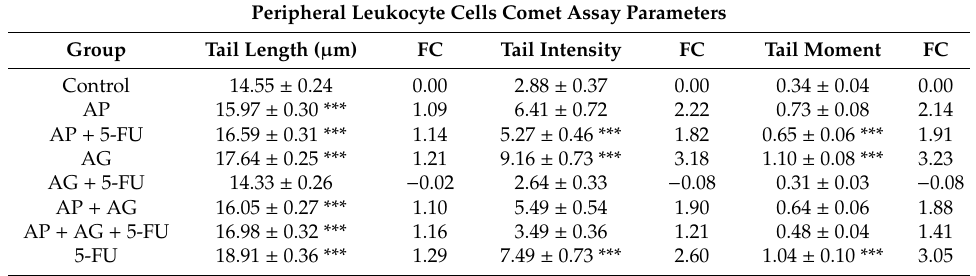
Table 7. E ff ect of treatment with Agarikon Plus, Agarikon.1 and 5-fluorouracil in various combinations on comet assay parameters as an indicator of DNA damage on peripheral leukocyte cells of Balb / c mice.